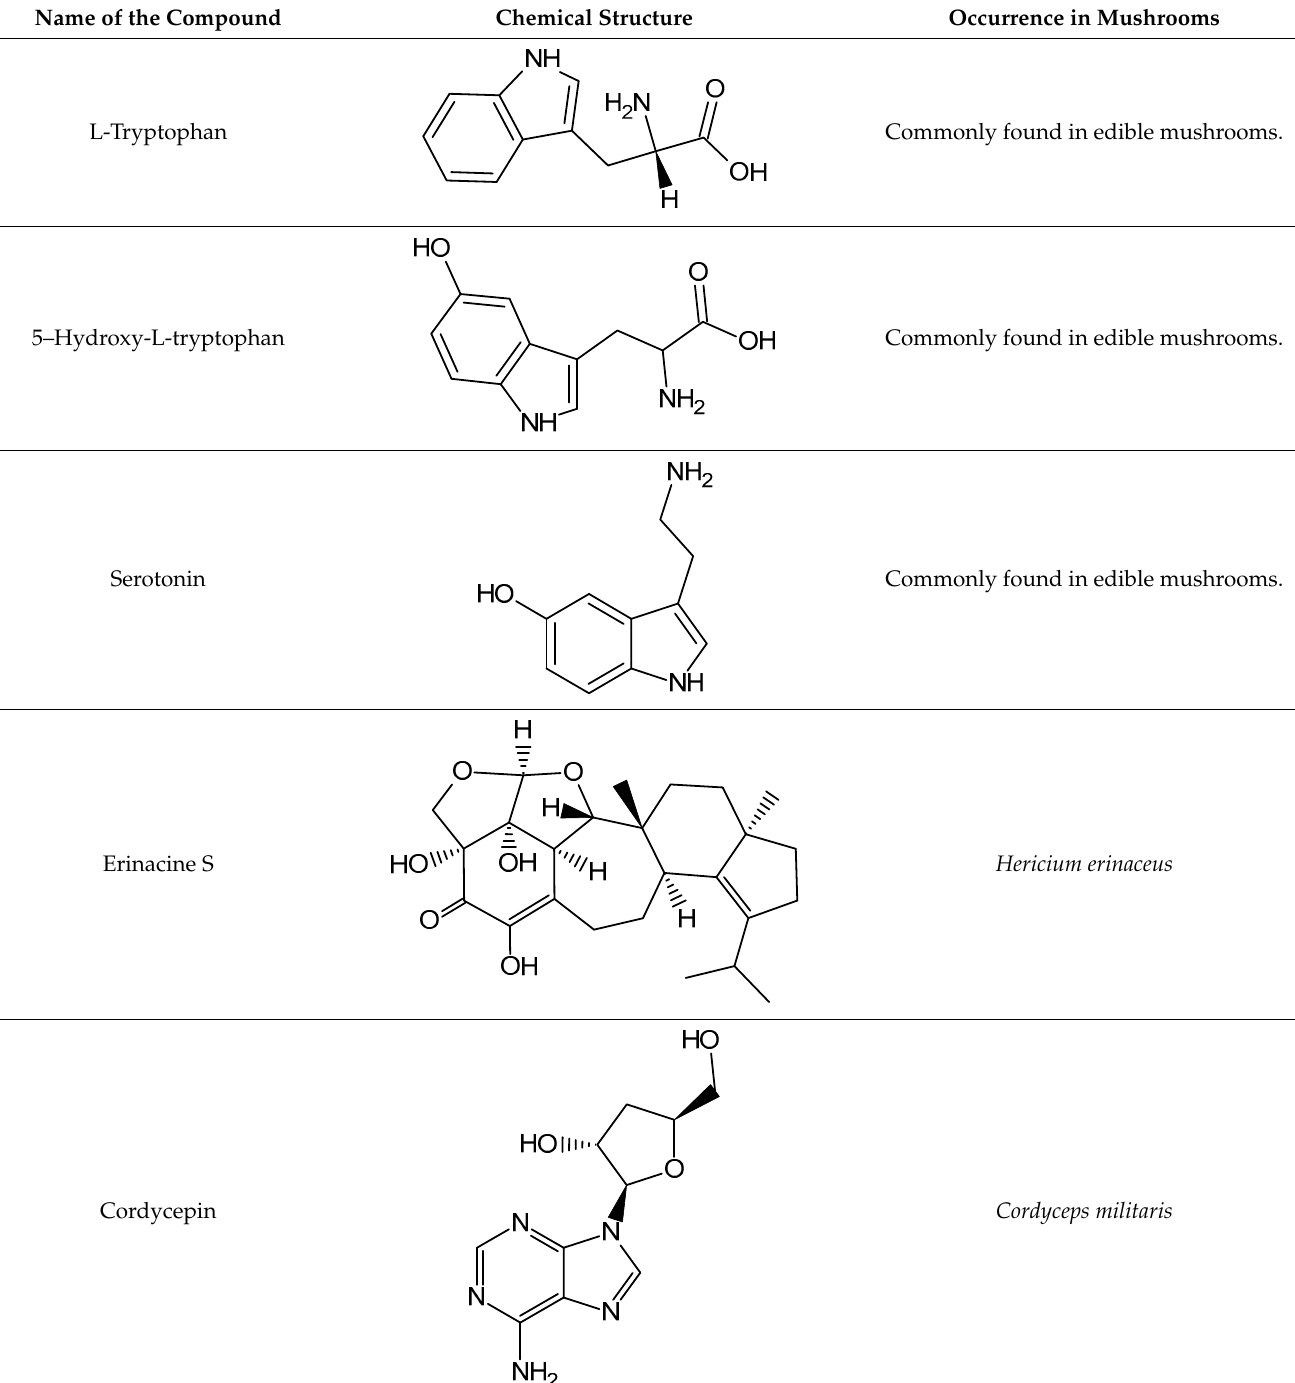
Figure 1. Hericium erinaceus in its natural habitat (photo by Pawe ł Stasiowski). Table 2. Chemical structures of bioactive compounds found in edible mushrooms.